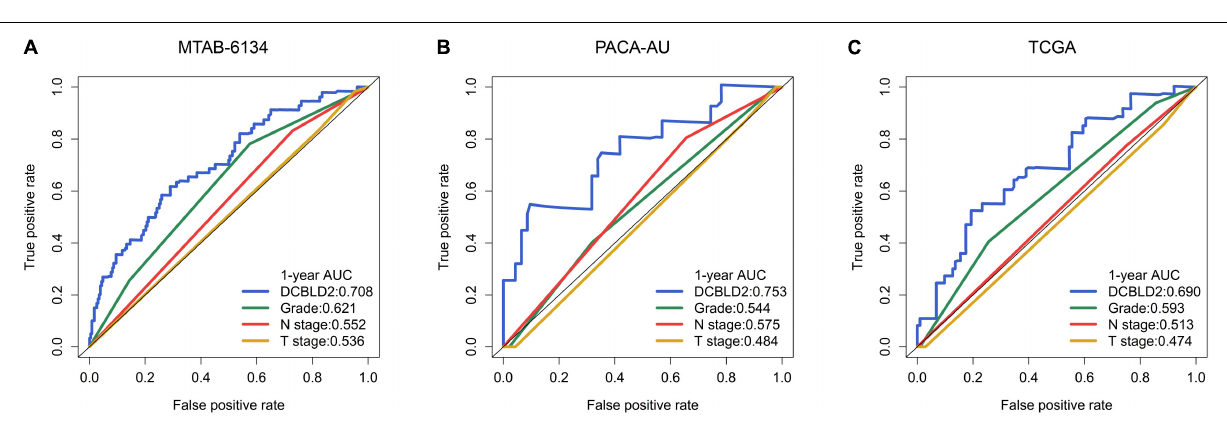
FIGURE 5 | Comparison of predictive accuracy of DCBLD2 and clinical parameters. (A–C) ROC curves compared the predictive abilities of DCBLD2 and clinical parameters for OS in the MTAB-6134, PACA-AU, and TCGA cohorts,